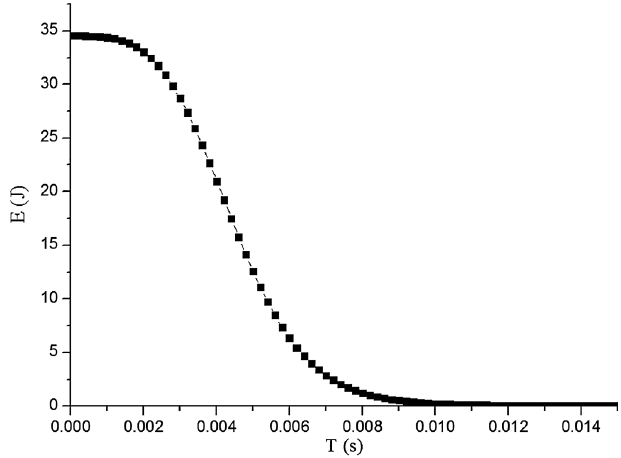
FIG. 8. Stored energy profile in the half-wave cavity.